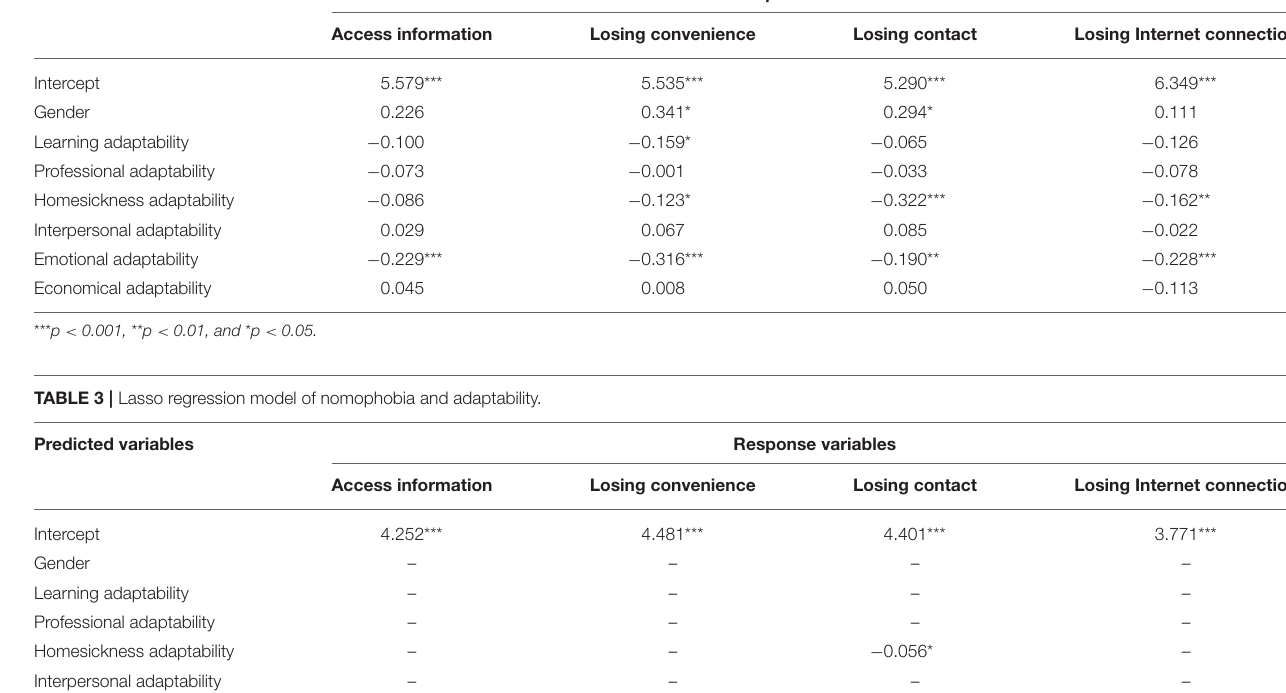
The Lasso Regression Model of Adaptability on Mobile Phone Addiction The dataset of mobile phone addiction and adaptability was used to verify the role of emotional adaptability and homesickness adaptability. In this part, collinearity diagnostics was used to test multicollinearity. Results showed that there was no multicollinearity among the independent variables in this